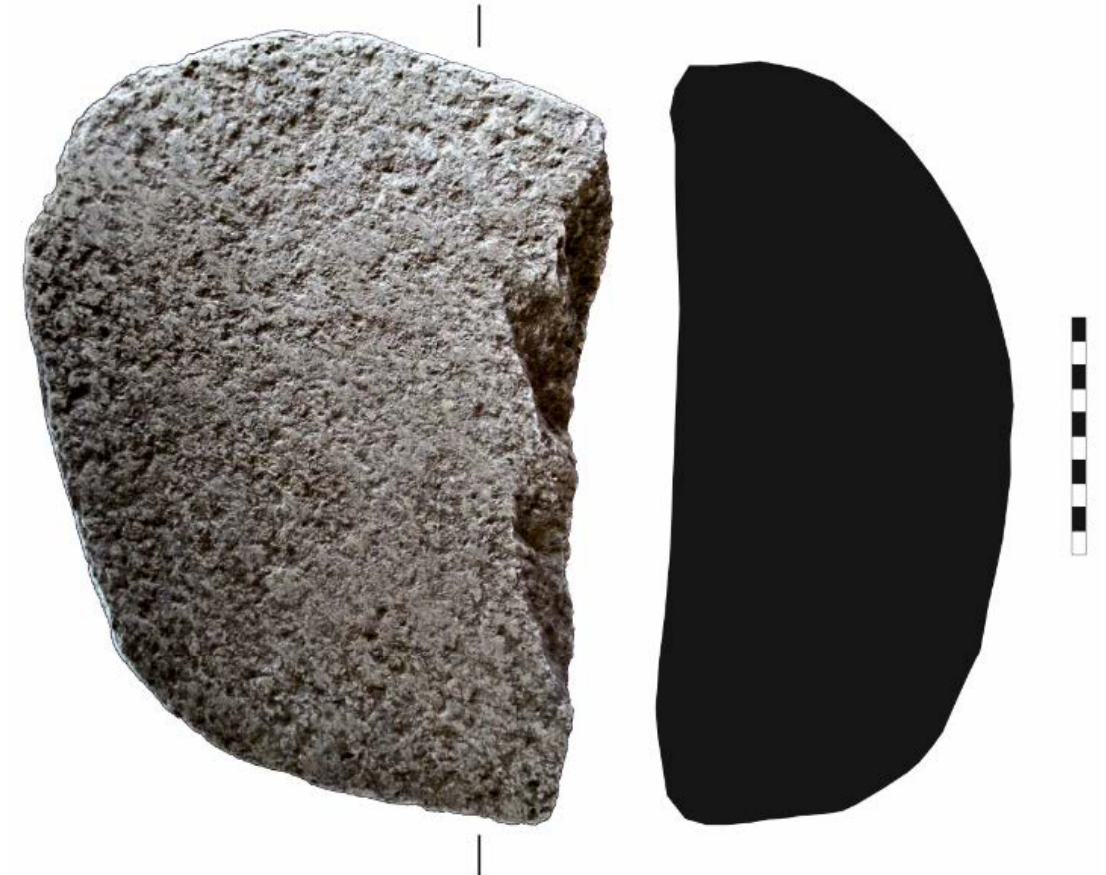
Figure 11. The grinding slab from Building 2a (AVGI I). Workface and width section (scale in